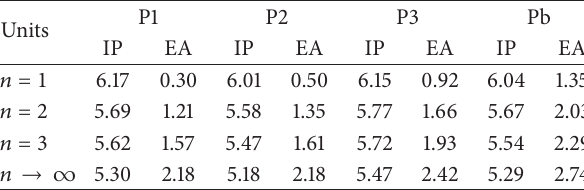
Table 3: Ionization potentials and electron affinities of P1, P2, P3, H-L and PBDT-BTA (Pb)